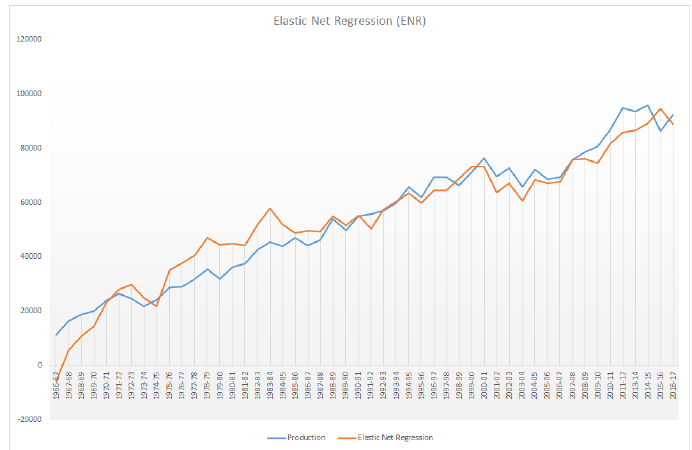
Figure 2: Forecasting using Elastic Net